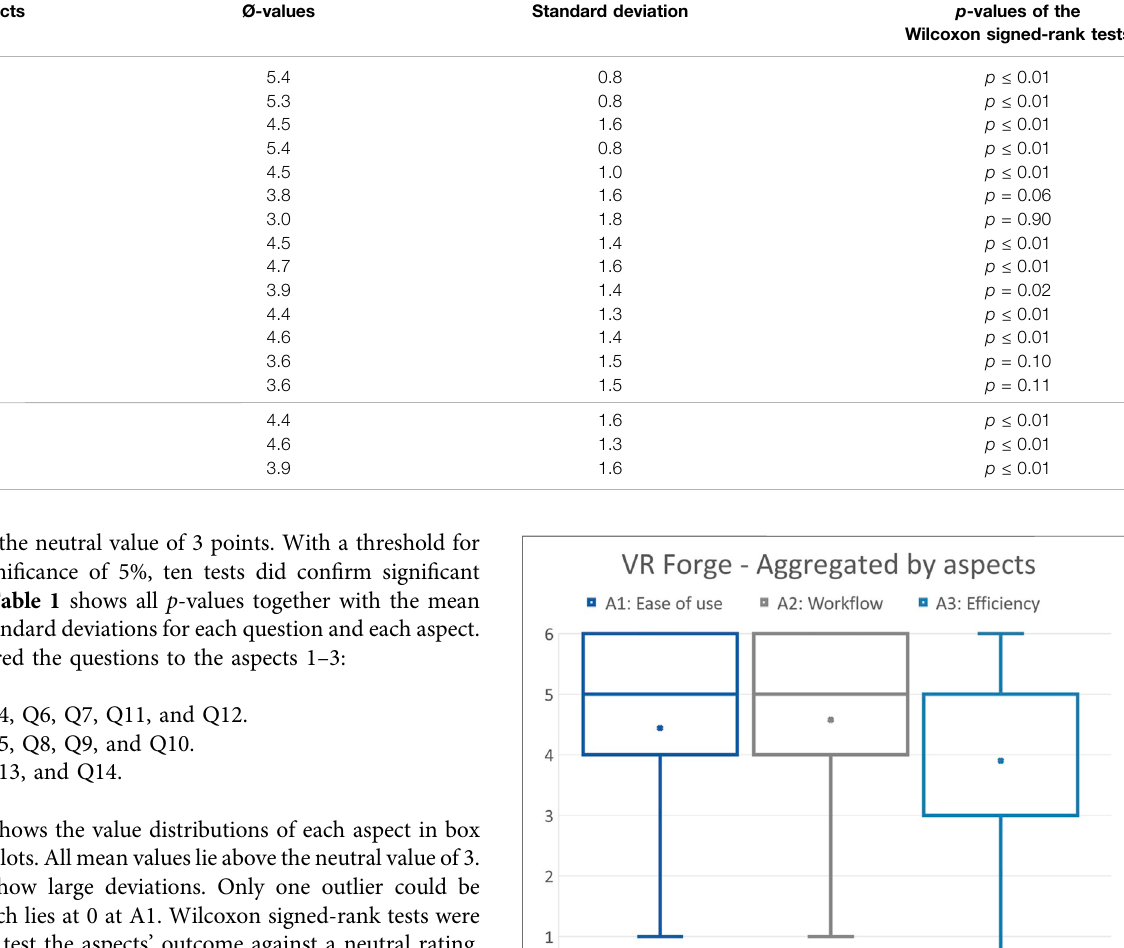
TABLE 1 | Mean values and output of the Wilcoxon signed-rank tests for Q1 – Q14 and A1 – A3. All values are rounded. 0 is the lowest, and 6 is the highest possible value. Questions/aspects Ø-values Standard deviation